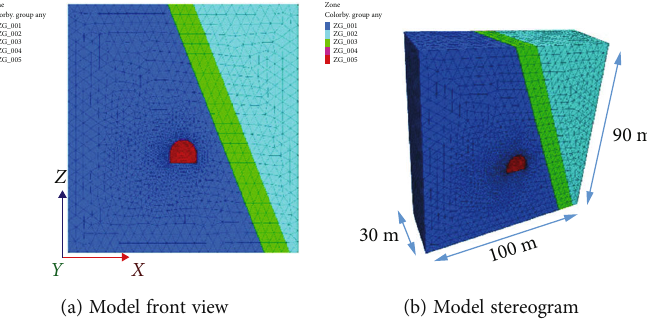
Figure 2: Three-dimensional calculation